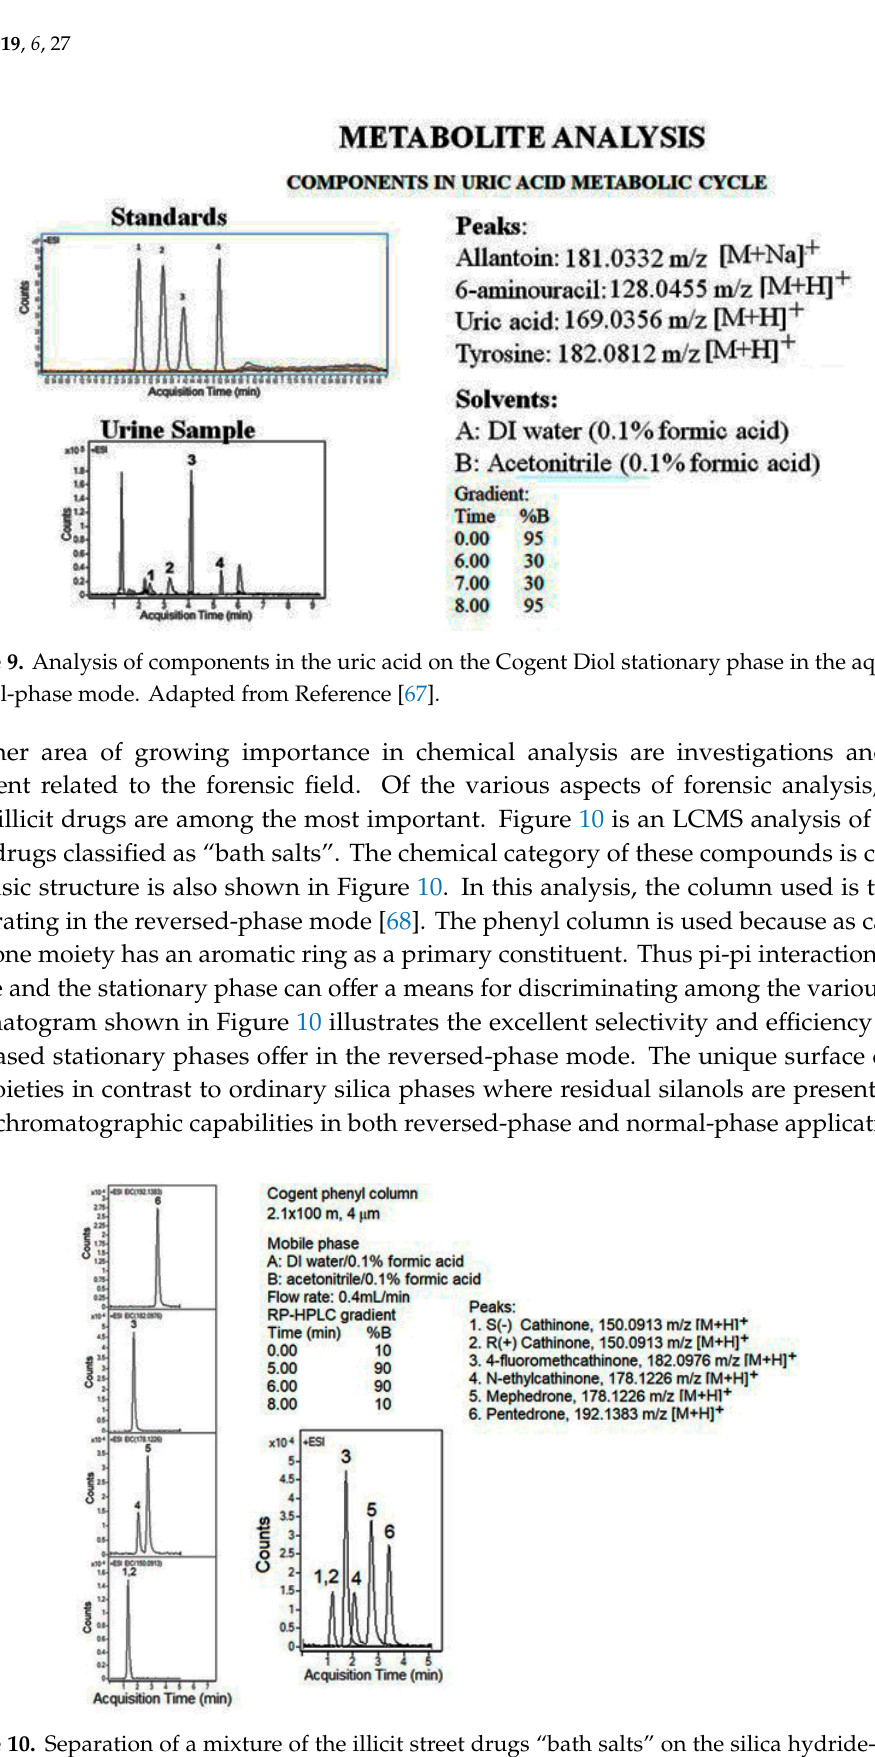
Figure 10. Separation of a mixture of the illicit street drugs “bath salts” on the silica hydride-based phenyl column in the reversed-phase mode. Data taken from Reference [68].